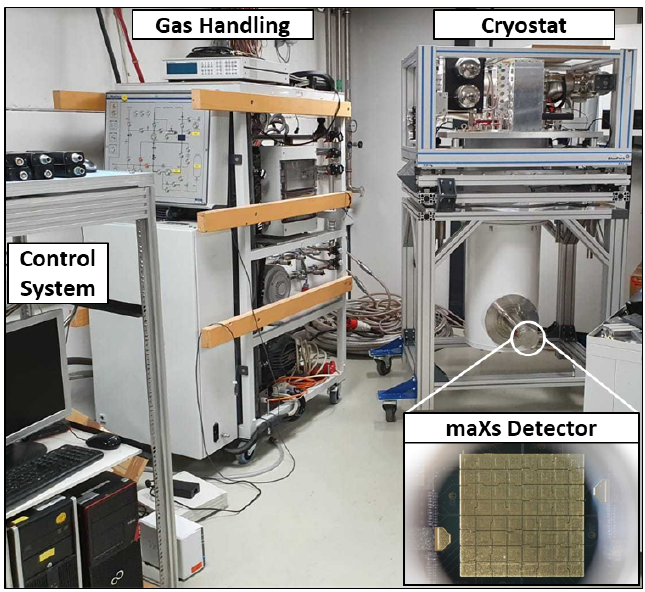
Figure 2. Photograph of setup necessary to operate a maXs-type detector at a test stand on the campus of GSI, Darmstadt, Germany. The inset shows the 8 × 8 absorber array.